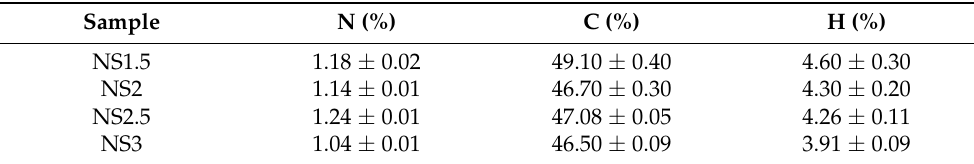
Table 2. Elemental analysis of nanosponges